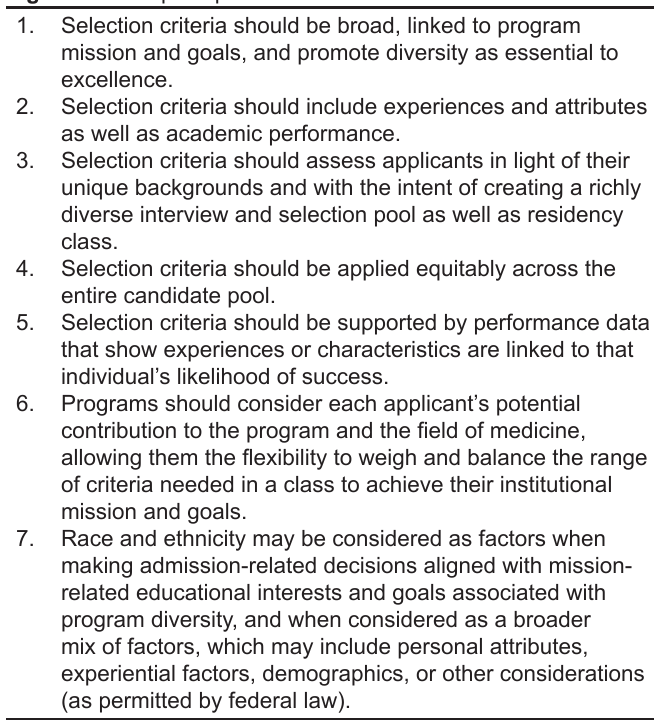
Figure 1. Core principles for holistic